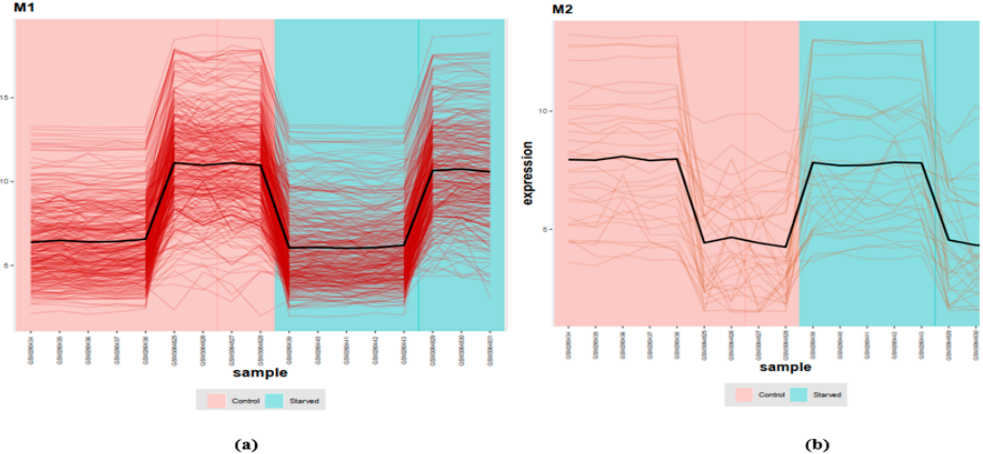
Figure 7. Expression profile of intra-gene modules (Module 1 (M1): a ; Module 2 (M2): b ) affected by starvation in zebrafish (red: control; green: starved).